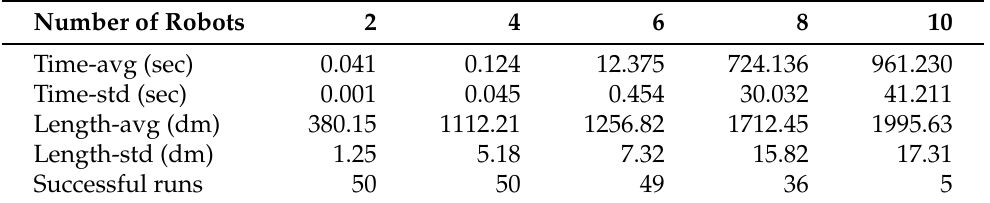
Table 2. Average and standard deviation for the execution time and total length of the robots’ paths over the number of successful runs yielded by the RRT* planner [4] for solving each scenario over 50